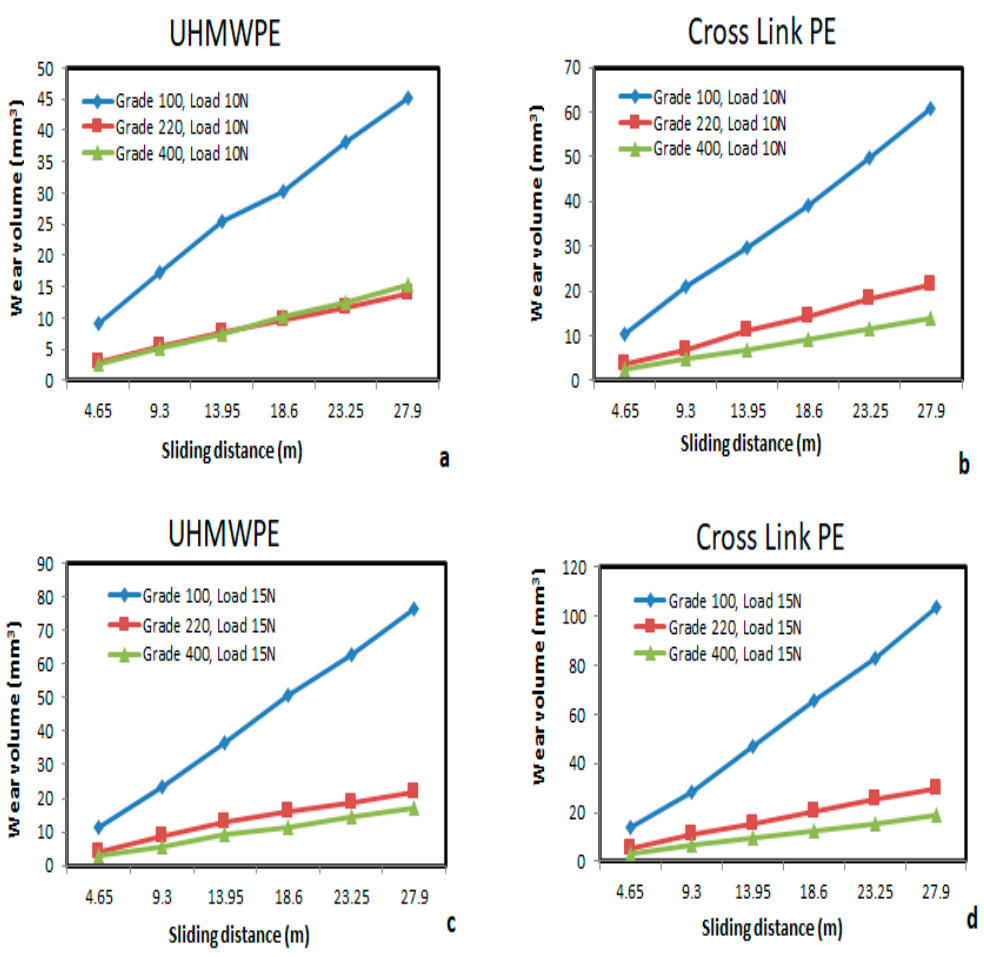
Figure 3. ( a – d ) Wear volume v/s sliding distance for UHMWPE and Cross Link PE at 10 N and 15 N loads with different grades of abrasive for wear test .